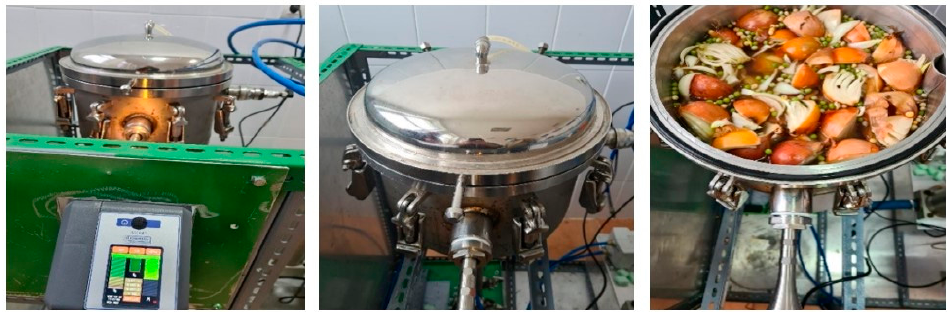
Figure 8. The experimental operation for the ultrasonic extraction mode.